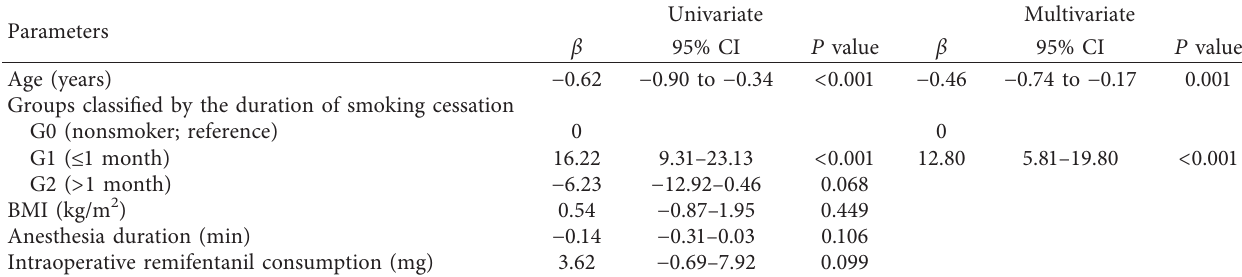
Table 2: Linear regression analysis of factors associated with the increased postoperative opioid requirement. Parameters